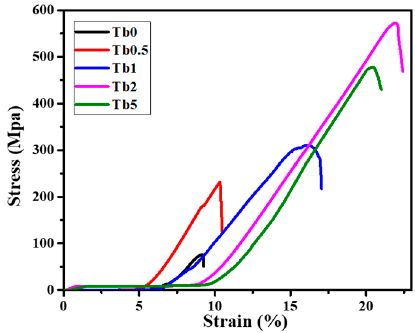
Figure 6. The compressive stress-strain curves of Ni 48 Mn 39 Sn 13 − x Tb x alloys.